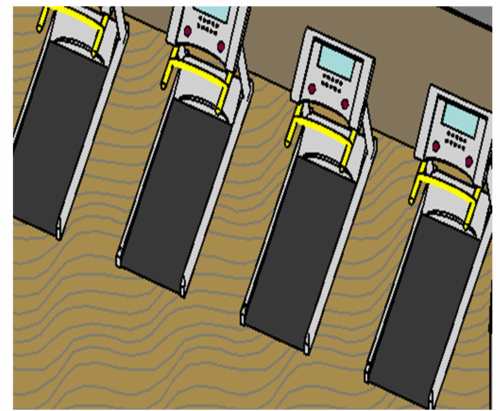
Figure 3. Fitness equipment in the BIM